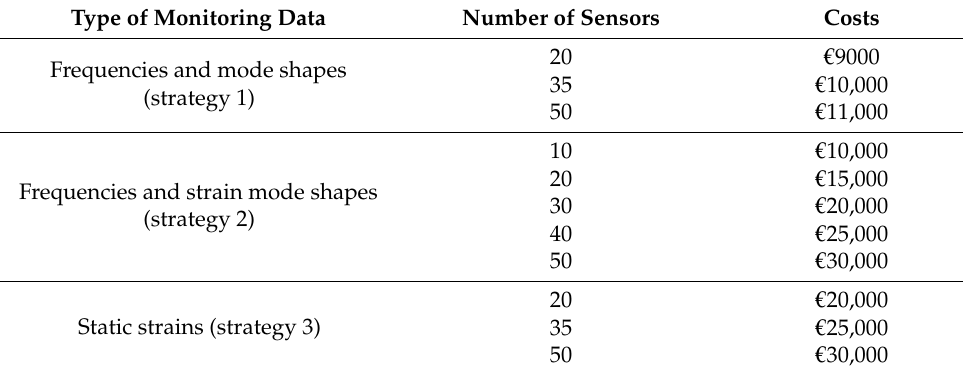
Table 2. Assumed monitoring costs for the example